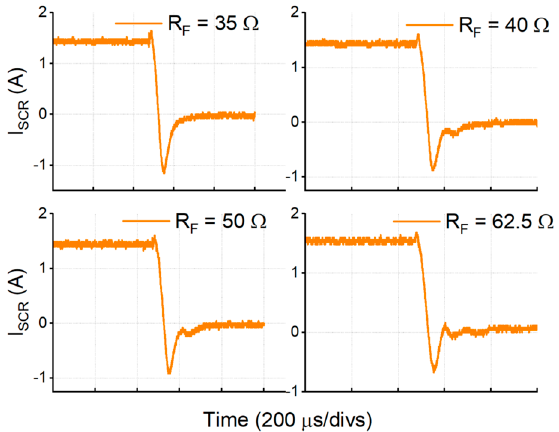
Figure 10. The ZCB’s cutoff behavior in the cases of the four-times multiplication factor.